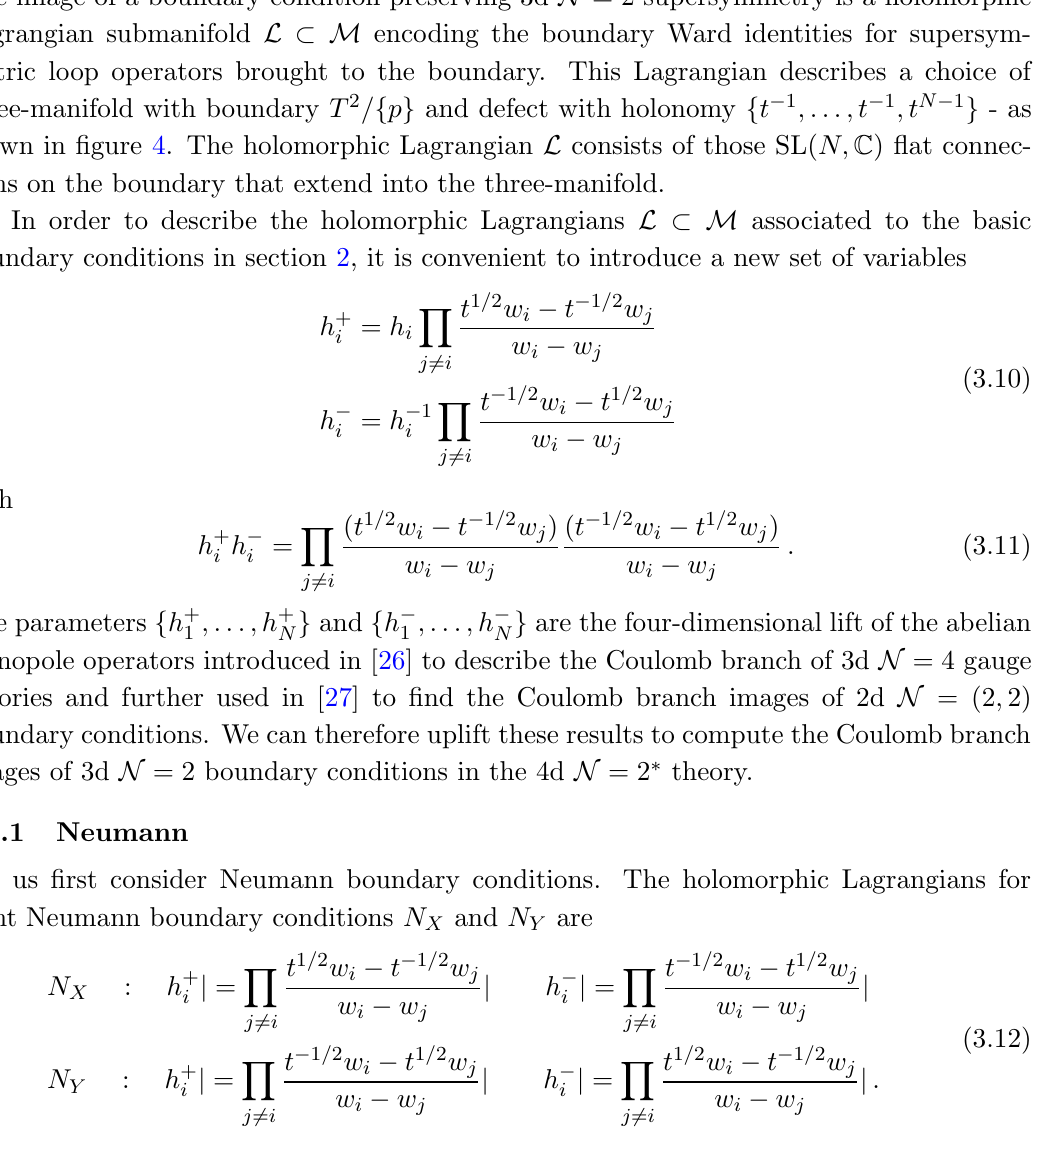
Figure 4 . Three-manifold M on the boundary T 2 =